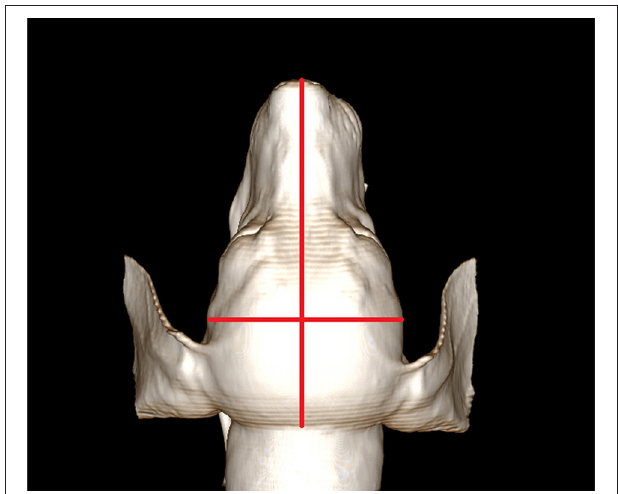
FIGURE 1 | Measurement of the cephalic index. For measuring the cephalic index, skull width is measured between the left and right zygomatic arch. The skull length is measured from the nose tip to the occipital protuberance. The cephalic index is calculated as skull width/skull length. Here, the cephalic index of this dog is